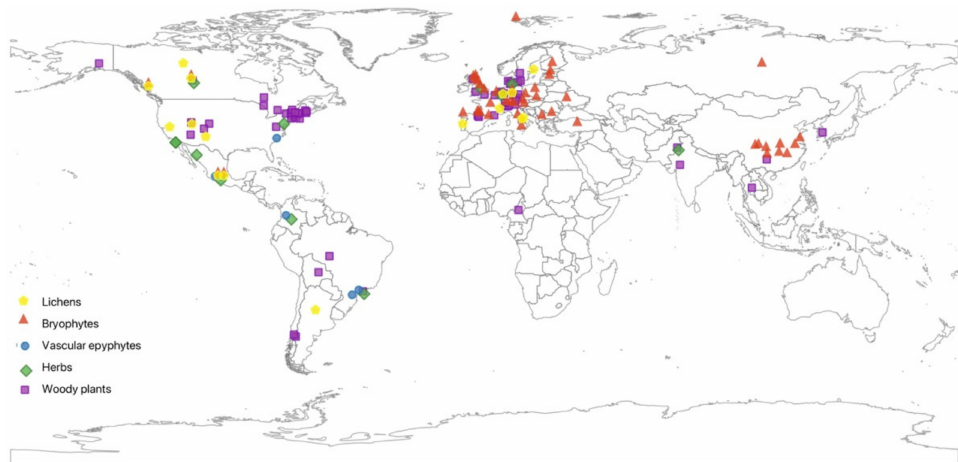
Figure 1. Biomonitoring experiences with lichens, bryophytes, vascular epiphytes, herbs, and woody plants. See underlying studies in the Supplementary